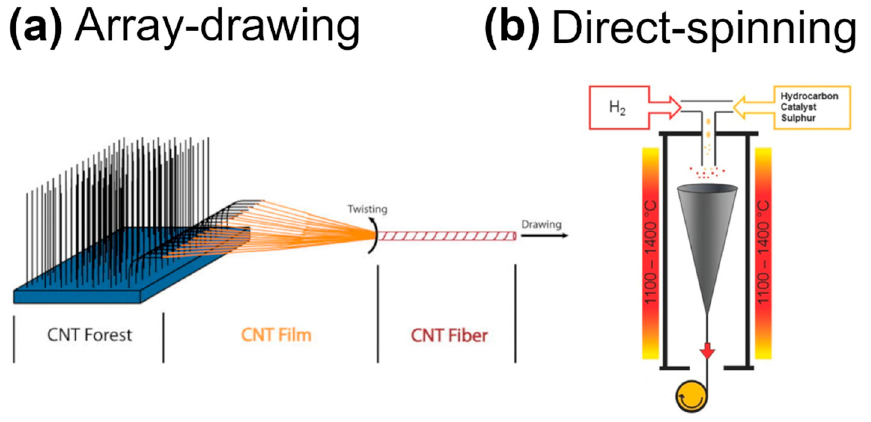
Figure 5. Solid-state formation of CNT fibers by ( a ) array-drawing reproduced with permission from [123], Copyright AIP Publishing LLC (2014); ( b ) direct-spinning modified and reproduced with permission from [107], Copyright The Authors